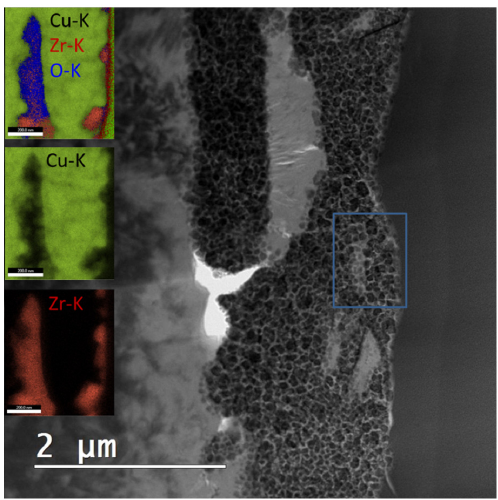
Figure 9. TEM overview image (main panel) and EDX maps (insets) of the operando ‐ activated Cu/Cu 51 Zr 14 metal ‐ intermetallic compound admixture. To visualize the chemical distribution, the Zr ‐ K, Cu ‐ K and O ‐ K intensities have been used.